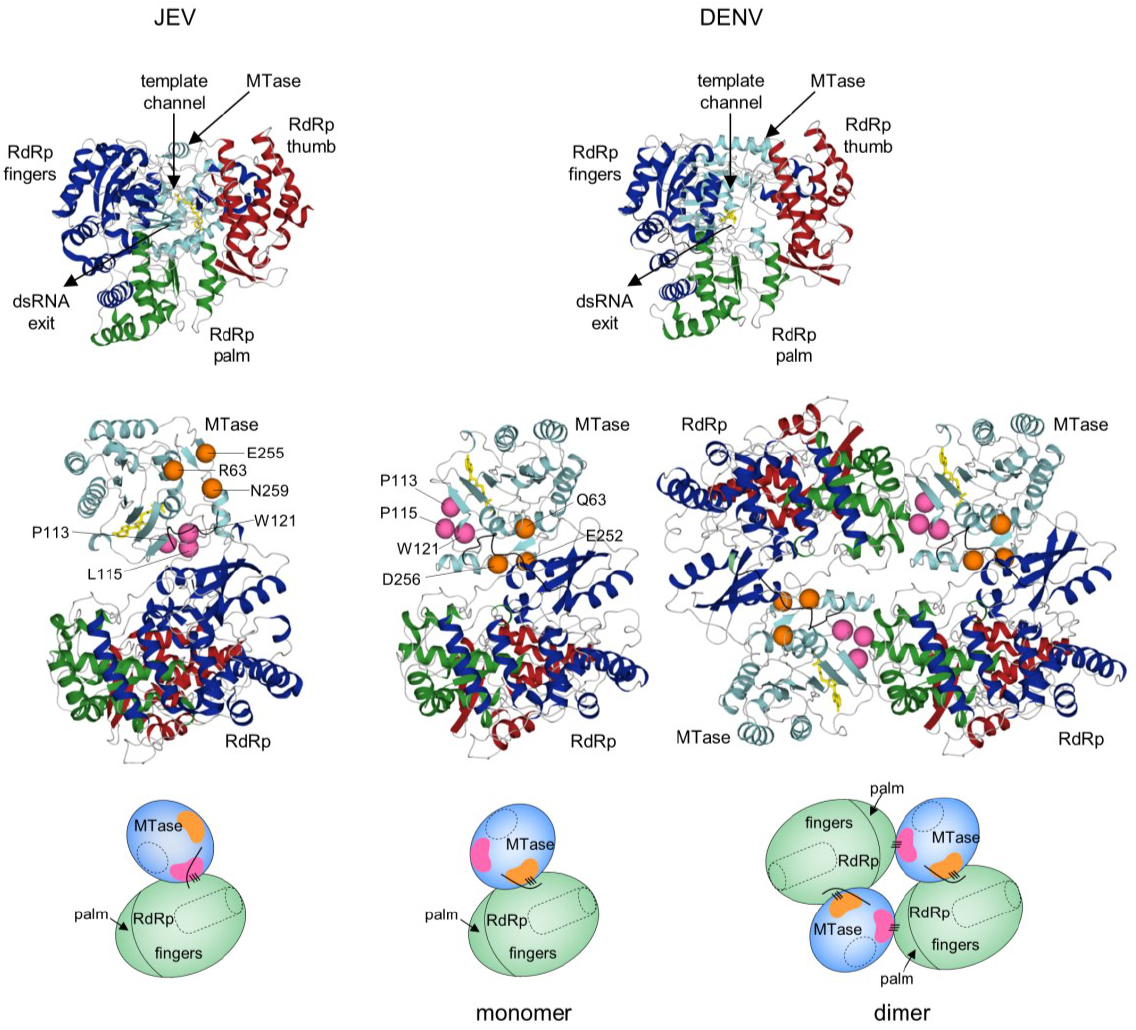
Figure 3. Comparison of full-length NS5 structures from JEV and DENV. Overall fold of JEV and DENV full-length NS5 (Protein Data Bank entries 4K6M and 4VOQ) are shown